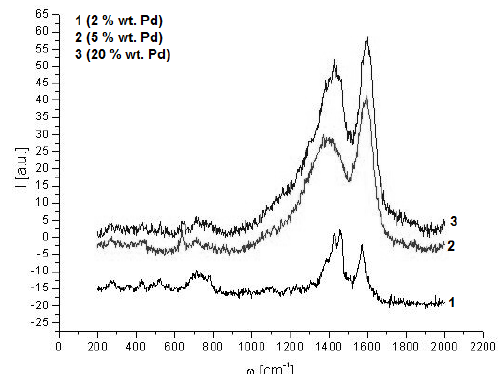
Figure 1. Raman spectra of C-Pd films with various Pd contents, obtained in PVD.